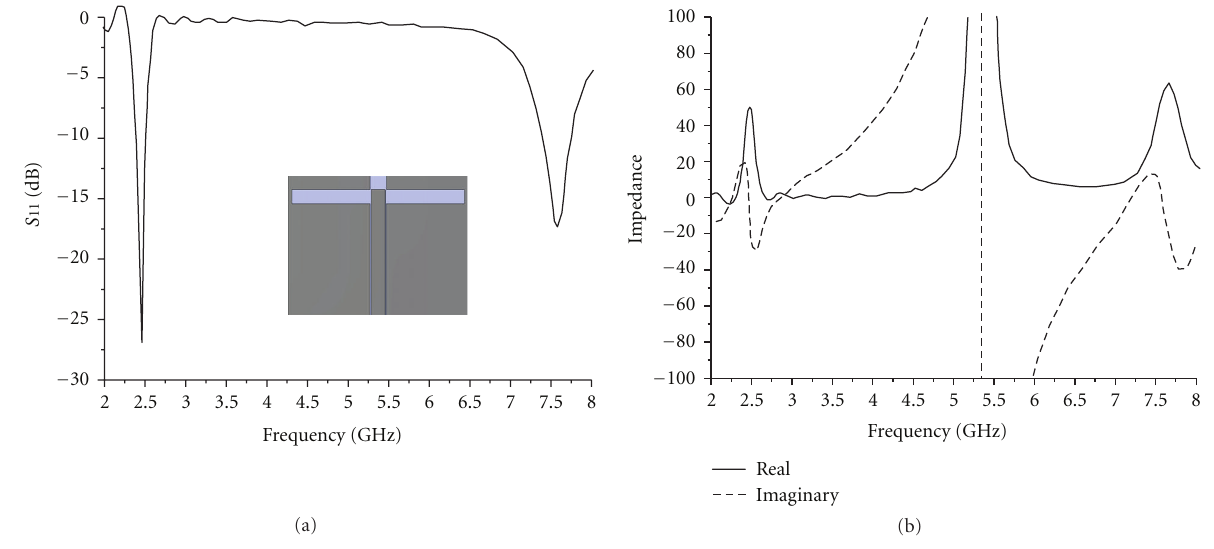
Figure 2: (a) The simulated return losses of antenna 1 and (b) The simulated input impedance of antenna